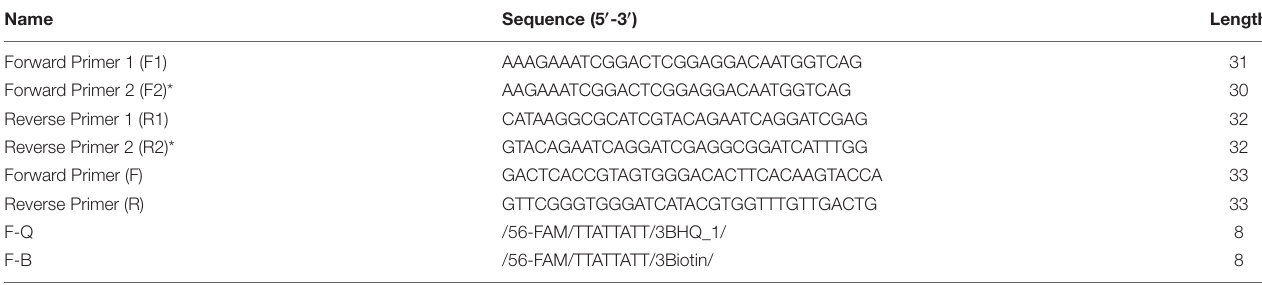
TABLE 1 | Primers and probes used in the ERA/CRISPR–Cas12 dual system.